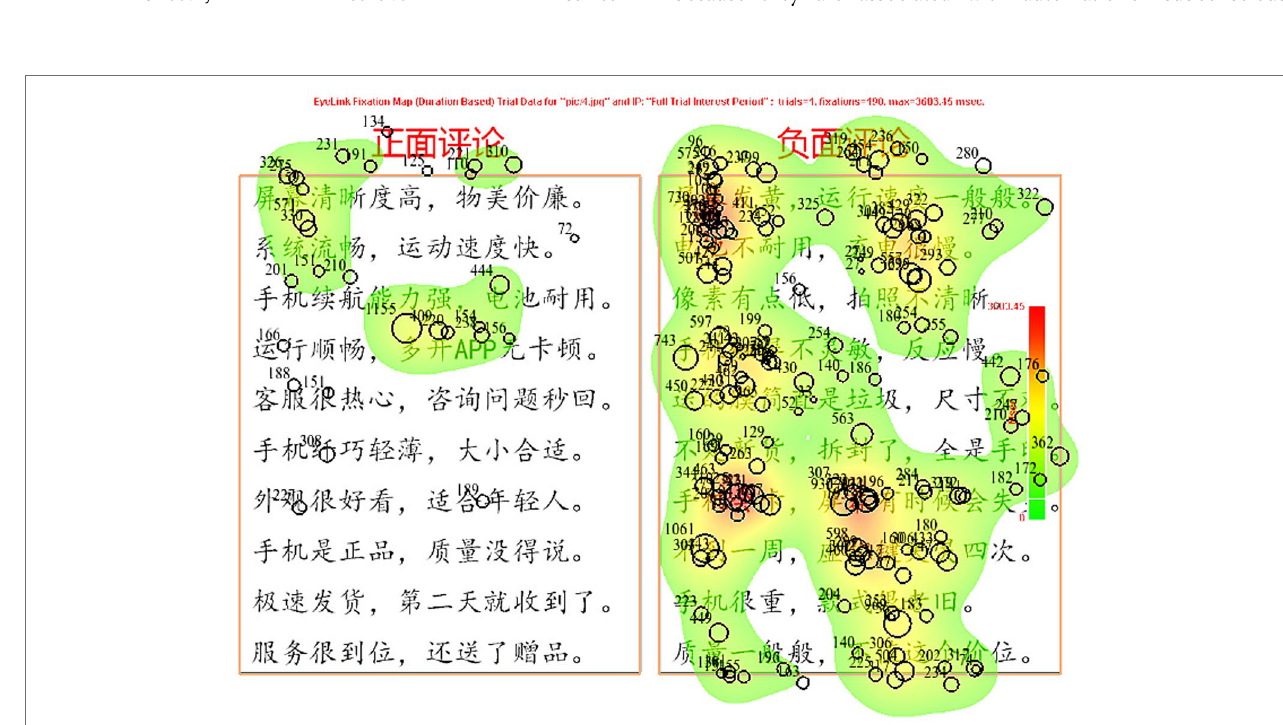
FIGURE 5 | Fixation count distribution.